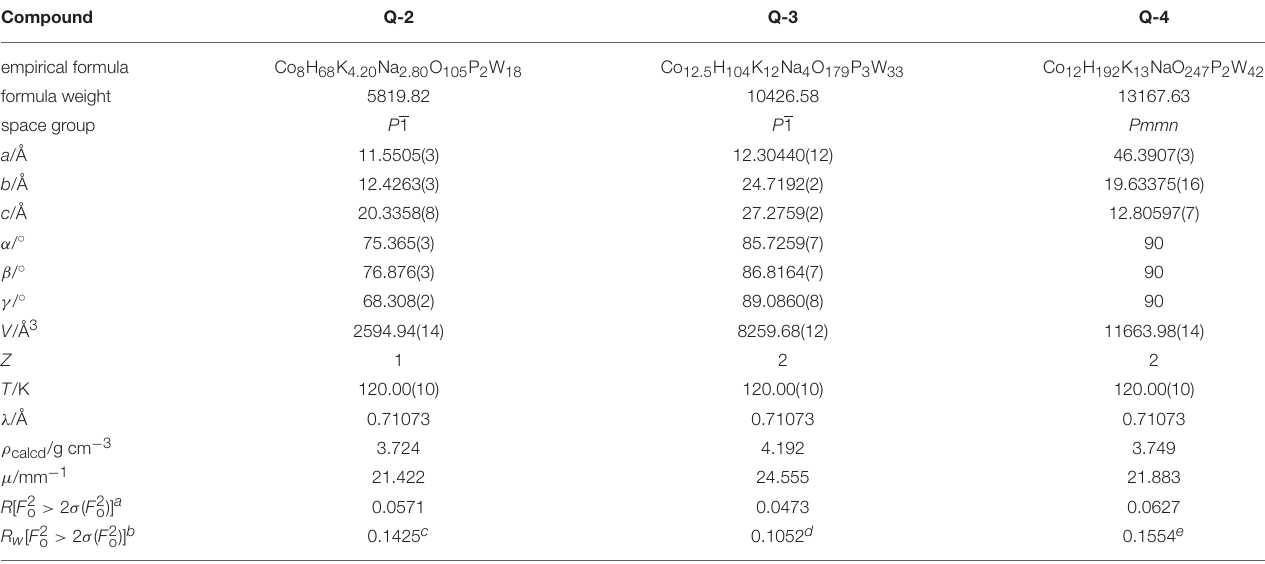
TABLE 1 | Crystallographic data for K 4.2 Na 2.8 [Co(H 2 O) 6 ][Co 7 (OH) 6 (H 2 O) 6 (PW 9 O 34 ) 2 ] · 19H 2 O ( Q-2 ),